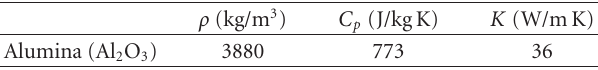
Table 4: Al 2 O 3 nanoparticle at temperature of 293 K [5–9].